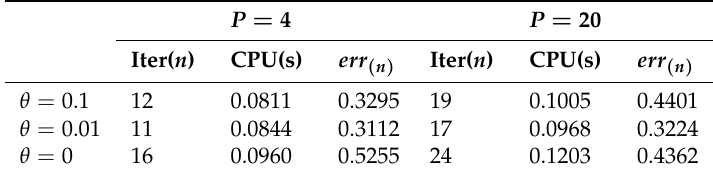
Table 3. Performance of Algorithm 1 for for different dimensions θ n , N = 3 with TOL = 10 − 3 . P = 4 P = 20 Iter( n ) CPU(s) err ( n ) Iter( n ) CPU(s) err ( n ) θ =